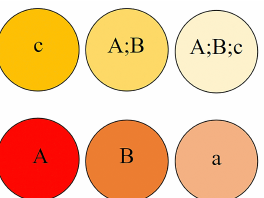
Figure 3. Sample AOI ordering scheme for the grid layout used in designing the networks in the DNet framework.